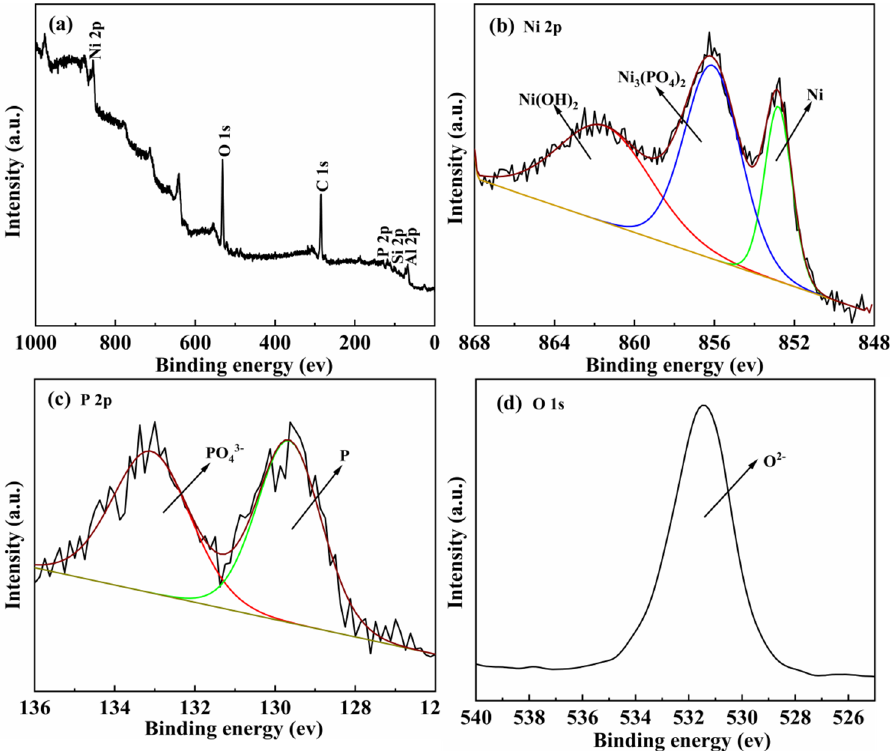
Figure 6. XPS spectra of Ni–P/mullite coated powder: ( a ) full spectra, ( b ) Ni 2p narrow spectra, ( c ) P 2p narrow spectra and ( d ) O 1s narrow spectra.